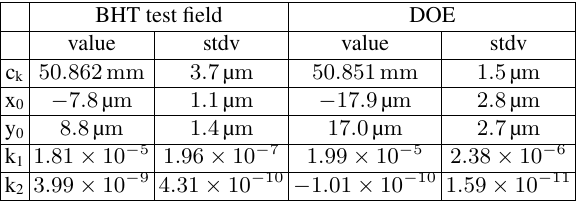
Table 1. Comparison of calibration results (Pixel Pitch of the camera is 7 . 4 µ m )